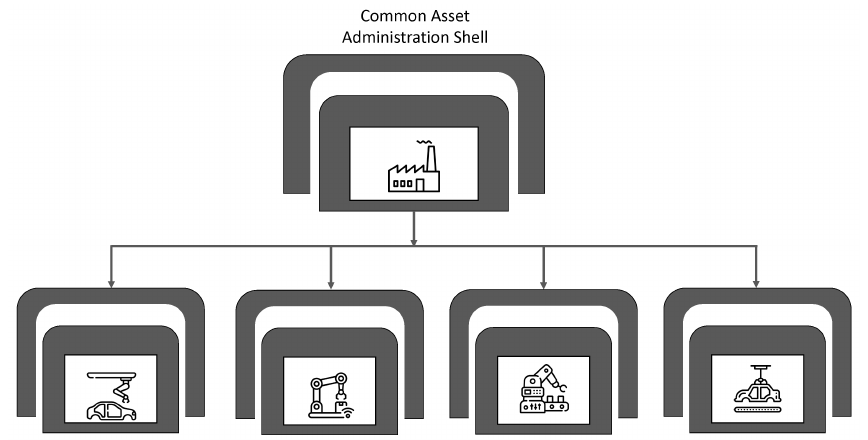
Figure 13. Common intra-factory asset administration shell.